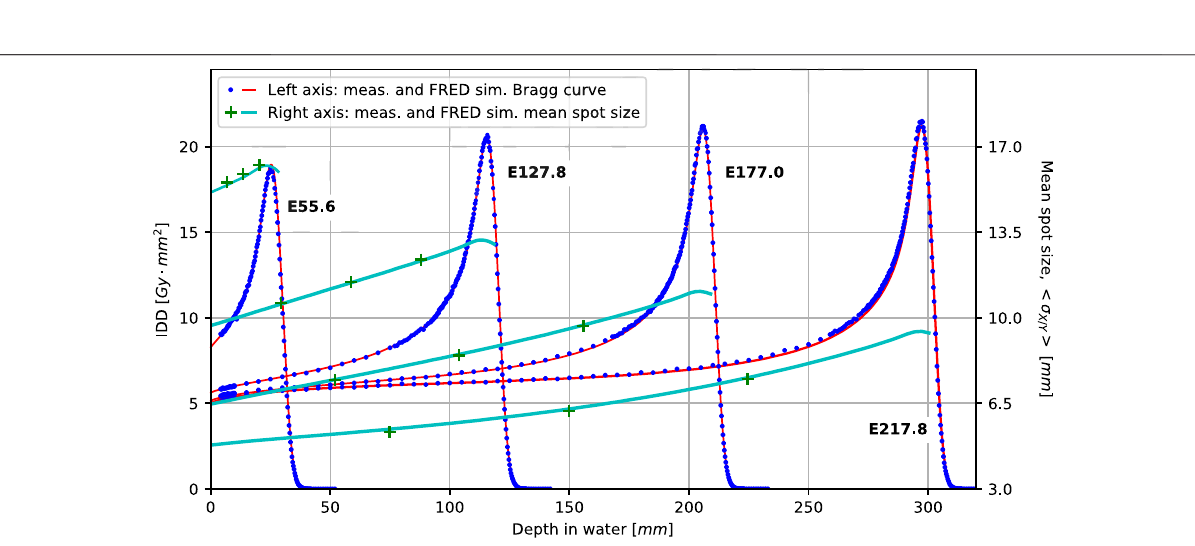
Frontiers in Physics |